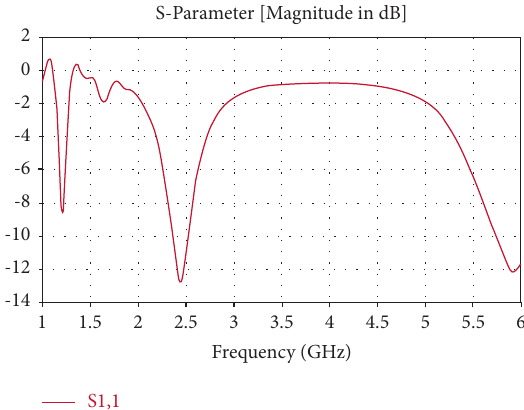
Figure 4: Reflection coefficient of the proposed design.